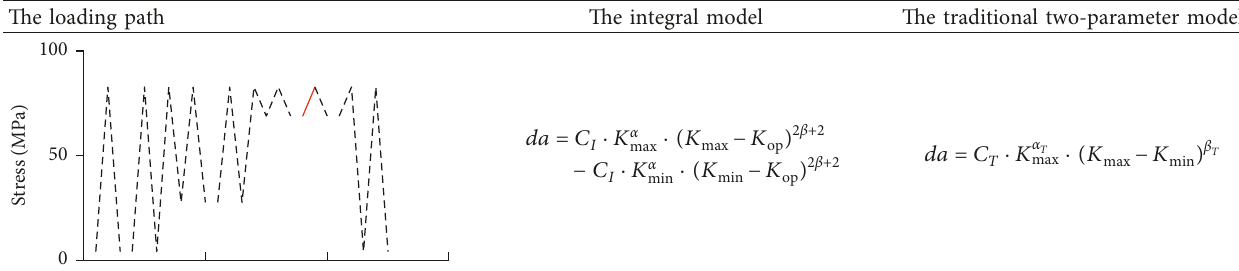
Table 4: The crack length in the loading path. The loading path The integral model The traditional two-parameter